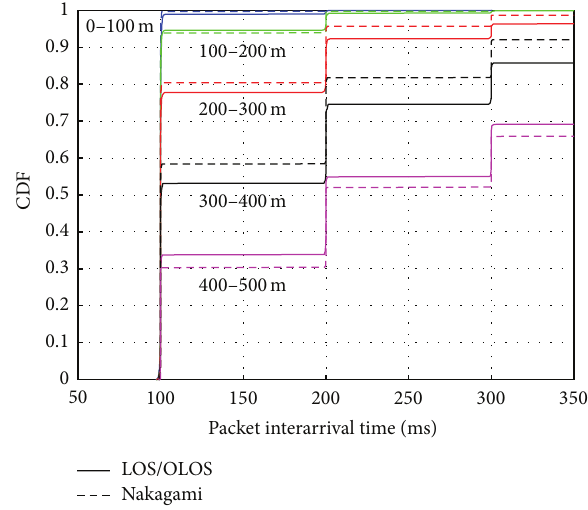
Figure 12: CDF for the packet interarrival time for a vehicle density of 60 vehicles/km for the LOS/OLOS and Nakagami models,